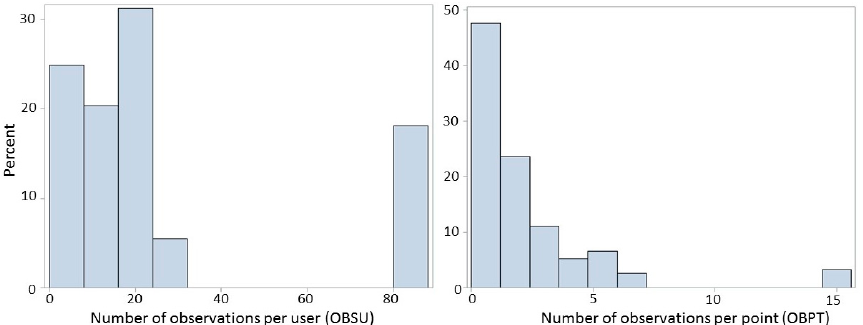
Figure 6. Histograms showing the data distribution in percent, highlighting outliers in the number of observations per point (OBPT) and per player (OBSU). Initial correlation analyses were run between the predictors before entering them in the models in order to control for collinearity. If collinearity was found, the decision on which predictor to